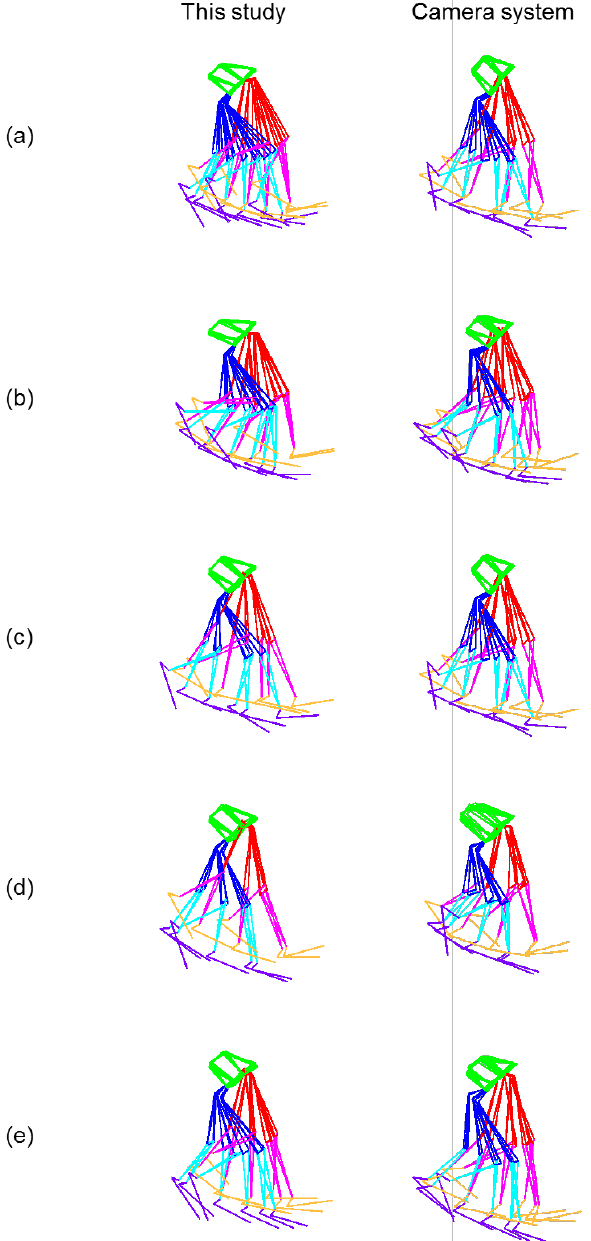
Figure 5. The figures on the left are the results obtained using this method and the right are those of the camera system. ( i ) The wire frame model representing gait of volunteers (a–e). The plot of the greater trochanter (GT), knee joint center and ankle joint center for the right leg ( ii ) and left leg ( iii ) during one gait cycle in the sagittal plane. The vertical axis represents the z axis and the horizontal axis represents the x axis in the global coordinate system. The plot of the knee joint center ( iv ) and ankle joint center ( v ) during one gait cycle in the horizontal plane. The vertical axis represents the x axis and the horizontal axis represents the y axis in the global coordinate system. The left knee is shown in red and the right in blue, the grey lines emanating from these lines represents the direction of the foot segment with respect to the ankle